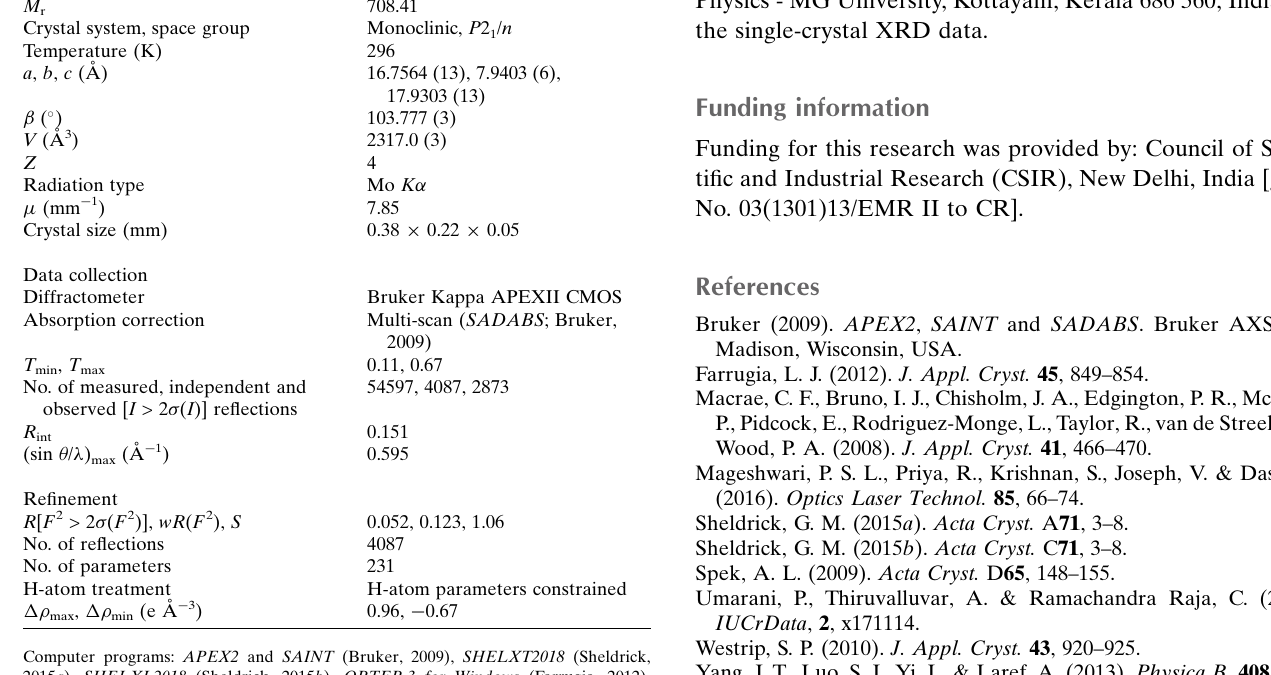
Table 2 Experimental details. Crystal data Chemical